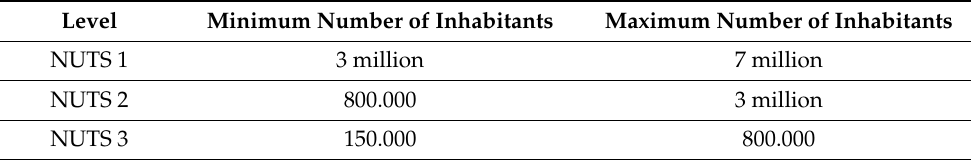
Table 1. Population size of the European Union’s administrative units